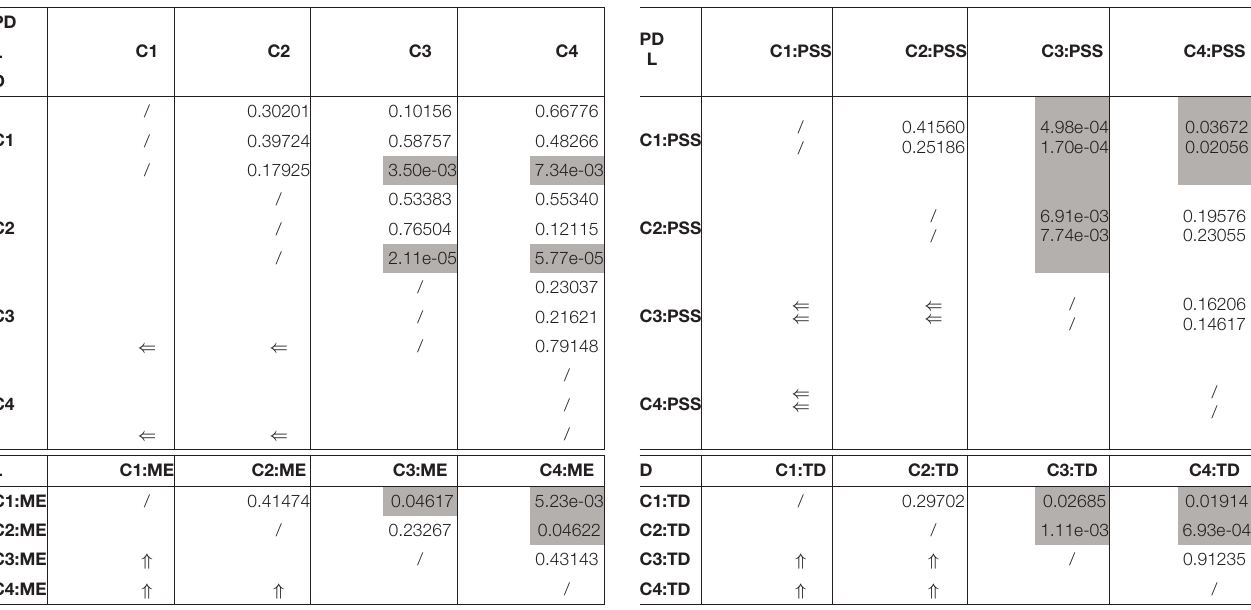
TABLE 3 | Resulting p -values when comparing the levels of multilevel categorical variables to each